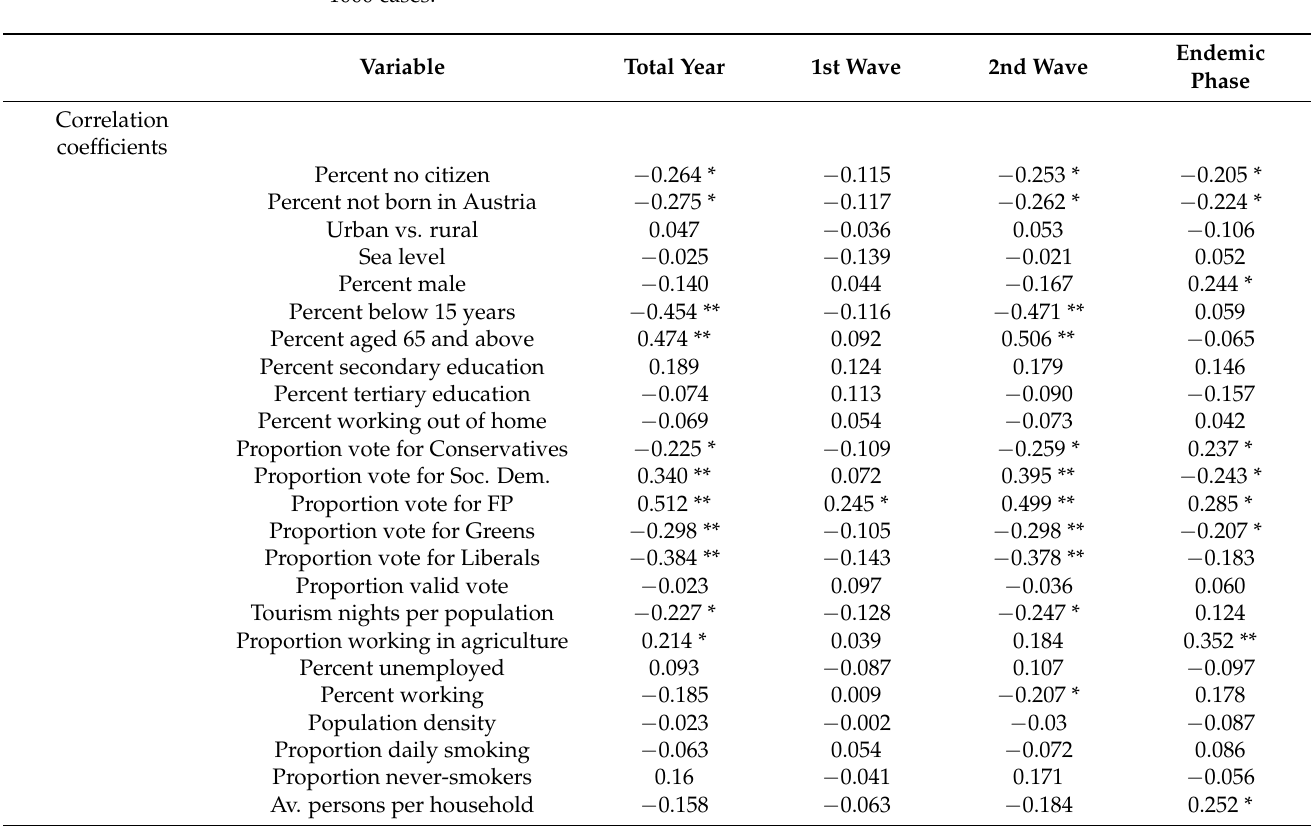
Table A3. Correlation coefficients between deaths per cases and the independent variable death per 1000